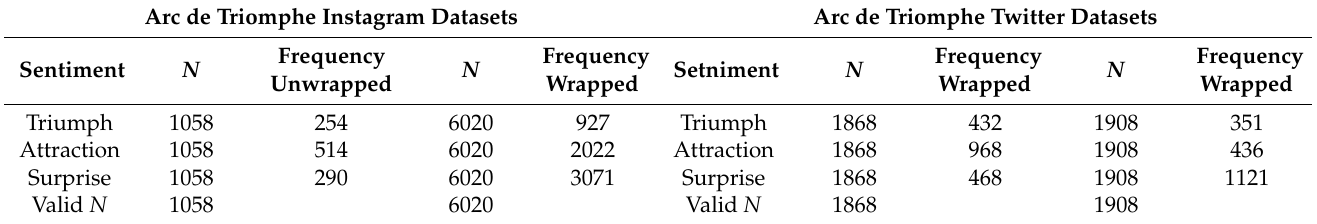
Table 4. The frequency of three sentiments in the Instagram and Twitter